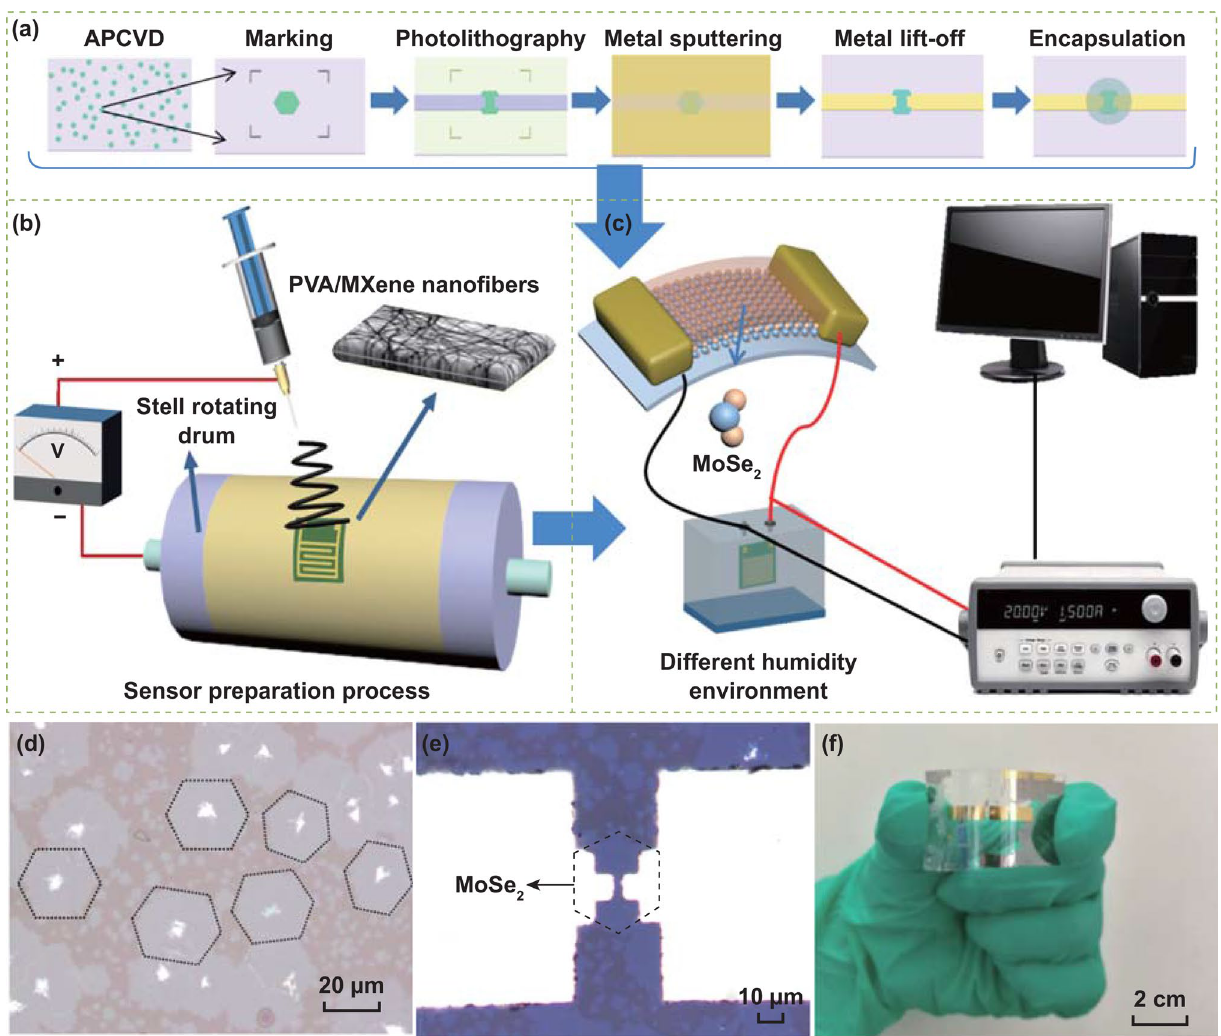
Fig. 1 Schematic diagram for the fabrication of a MoS ⁠ e 2 -flake-based PENG and b PVA/MXene humidity sensor. c Schematic of the experimen- tal platform for humidity sensing measurement. d Monolayer MoSe 2 prepared by APCVD. e Optical microscope image of a MoSe 2 piezoelectric device with two electrodes. f Photograph of the flexible PENG